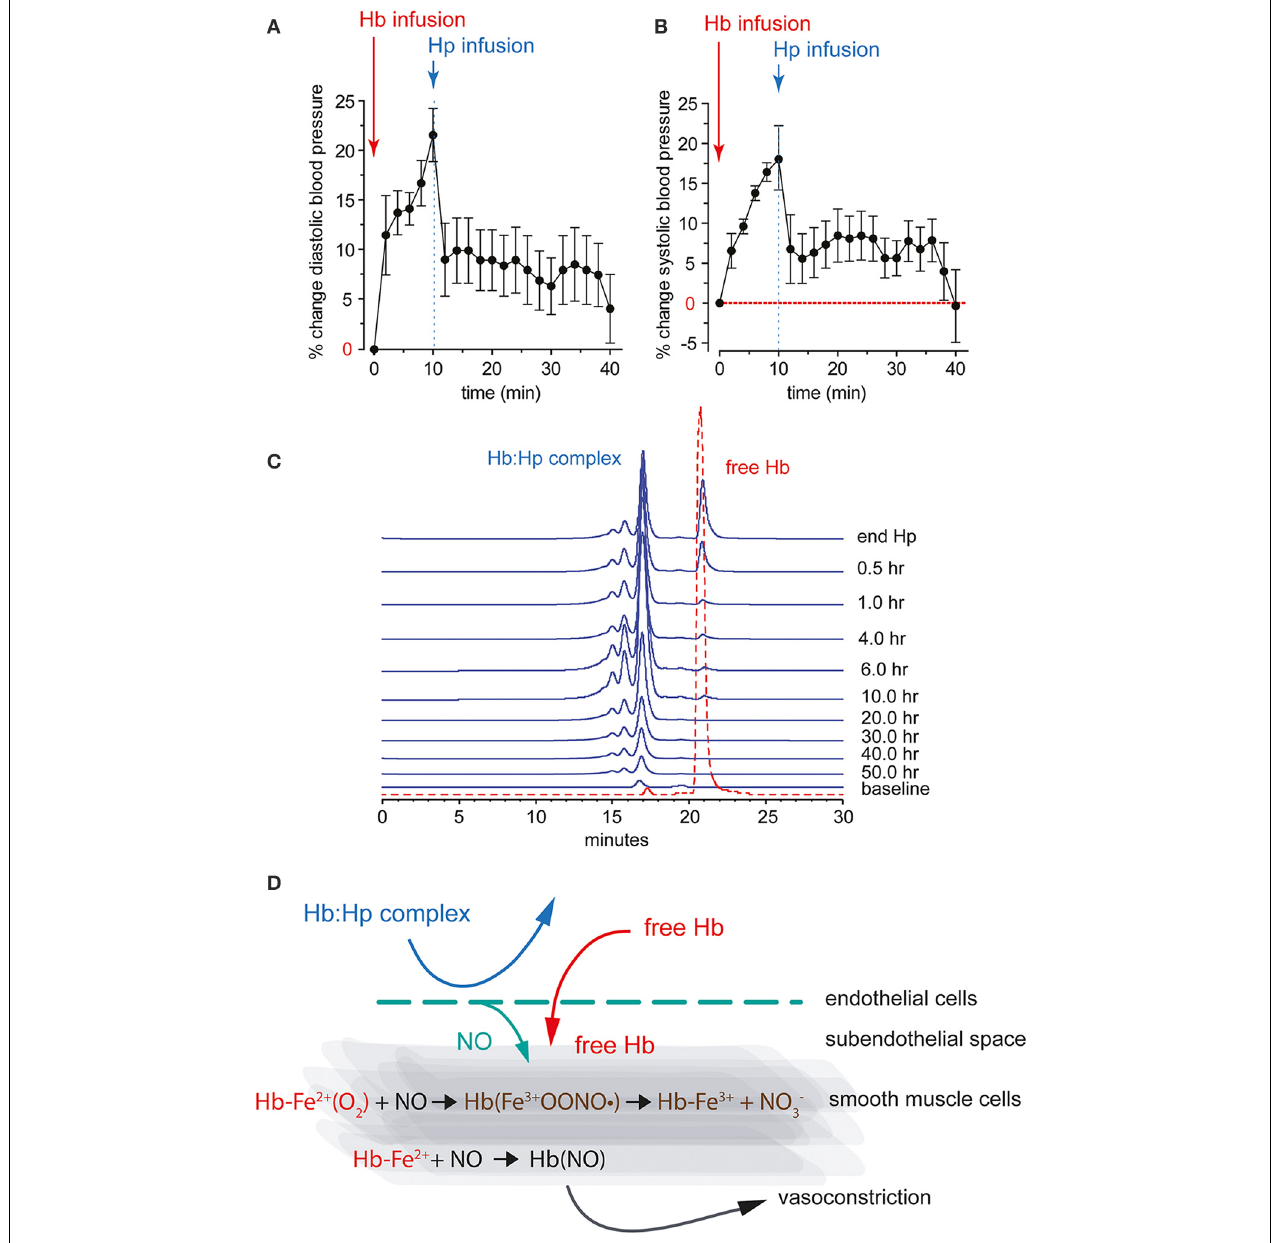
FIGURE 2 | Diastolic (A) and systolic (B) systemic arterial blood pressure response after bolus infusion of free Hb followed by a bolus infusion of purified human Hp in guinea pigs. (C) HPLC analysis of guinea pig plasma after infusion of free Hb followed by Hp. The traces show free Hb co-eluting with an Hb standard (red). The Hb-Hp complex has a larger molecular weight, as indicated by the earlier elution time. The Hb-Hp complex has a long circulation half-life with detectable levels up to